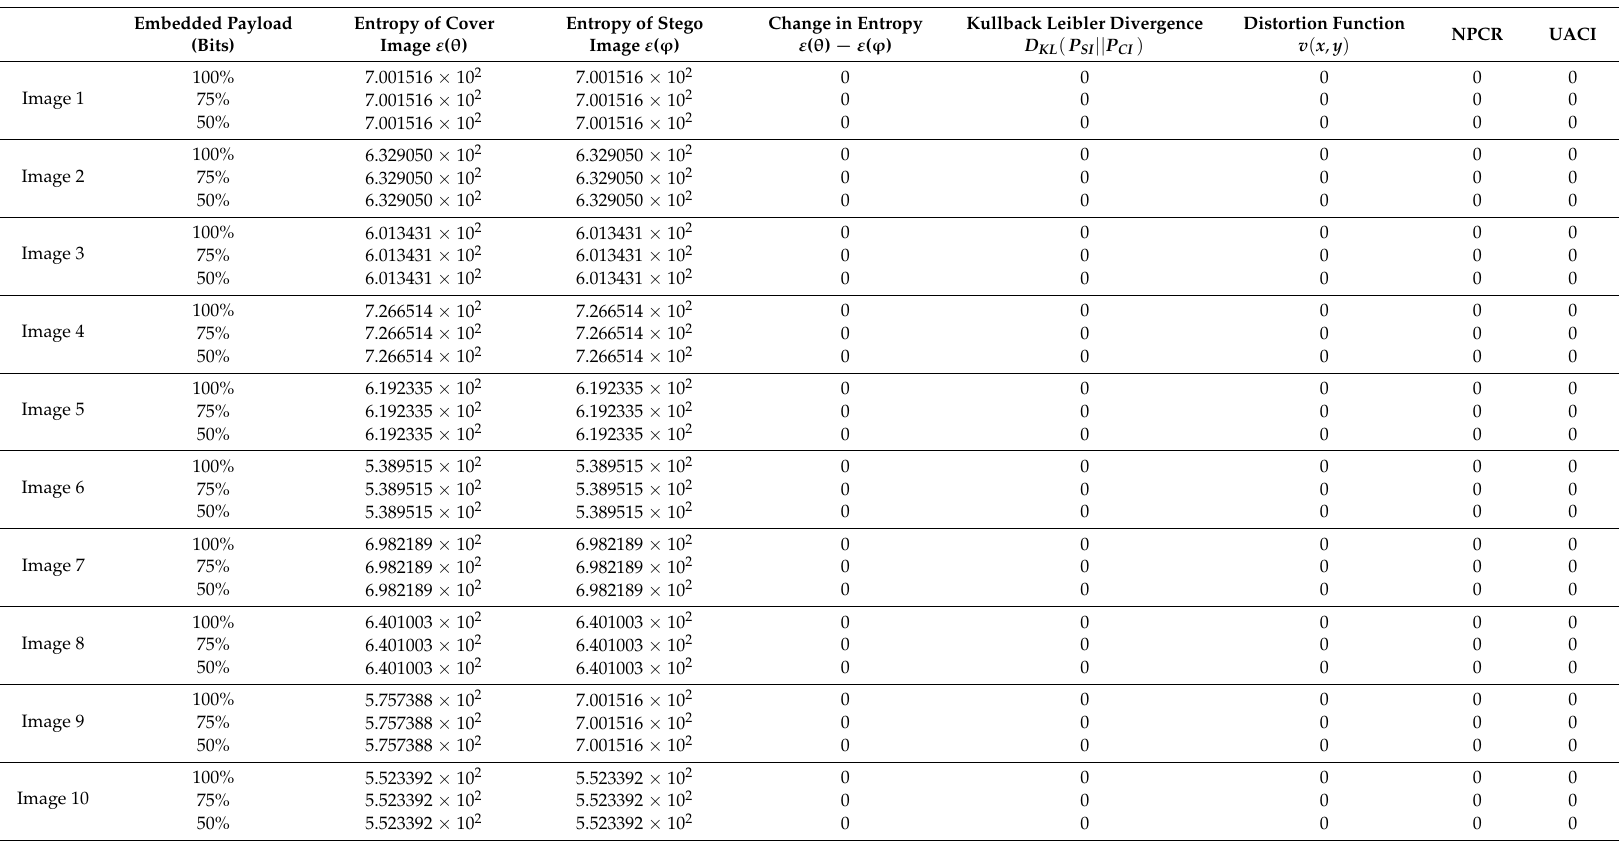
Table 2. Computational results for entropy, Kullback Leibler divergence, distortion function, Difference Number of Pixel Change Rate (NPCR), and Unified Average Changing Intensity (UACI) after different embedding payload for each